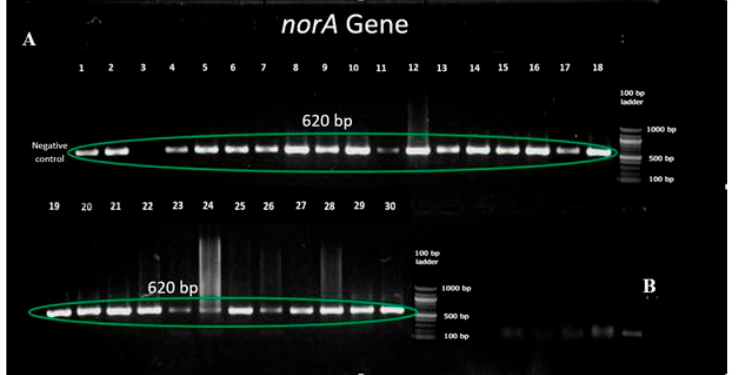
Figure 2. ( A , B ) Detection of norA gene in the clinical isolates using PCR and gel Figure 2. Detection of norA gene in the clinical isolates using PCR and gel electrophoresis.